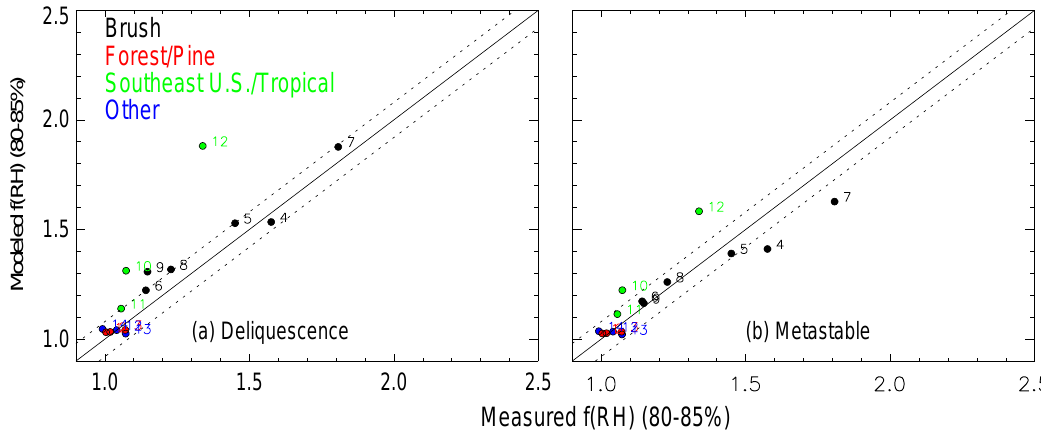
Fig. 8. Comparisons of measured and modeled f ( RH) for RH=80–85% for (a) deliquescence, (b) metastable equilibrium derived using the